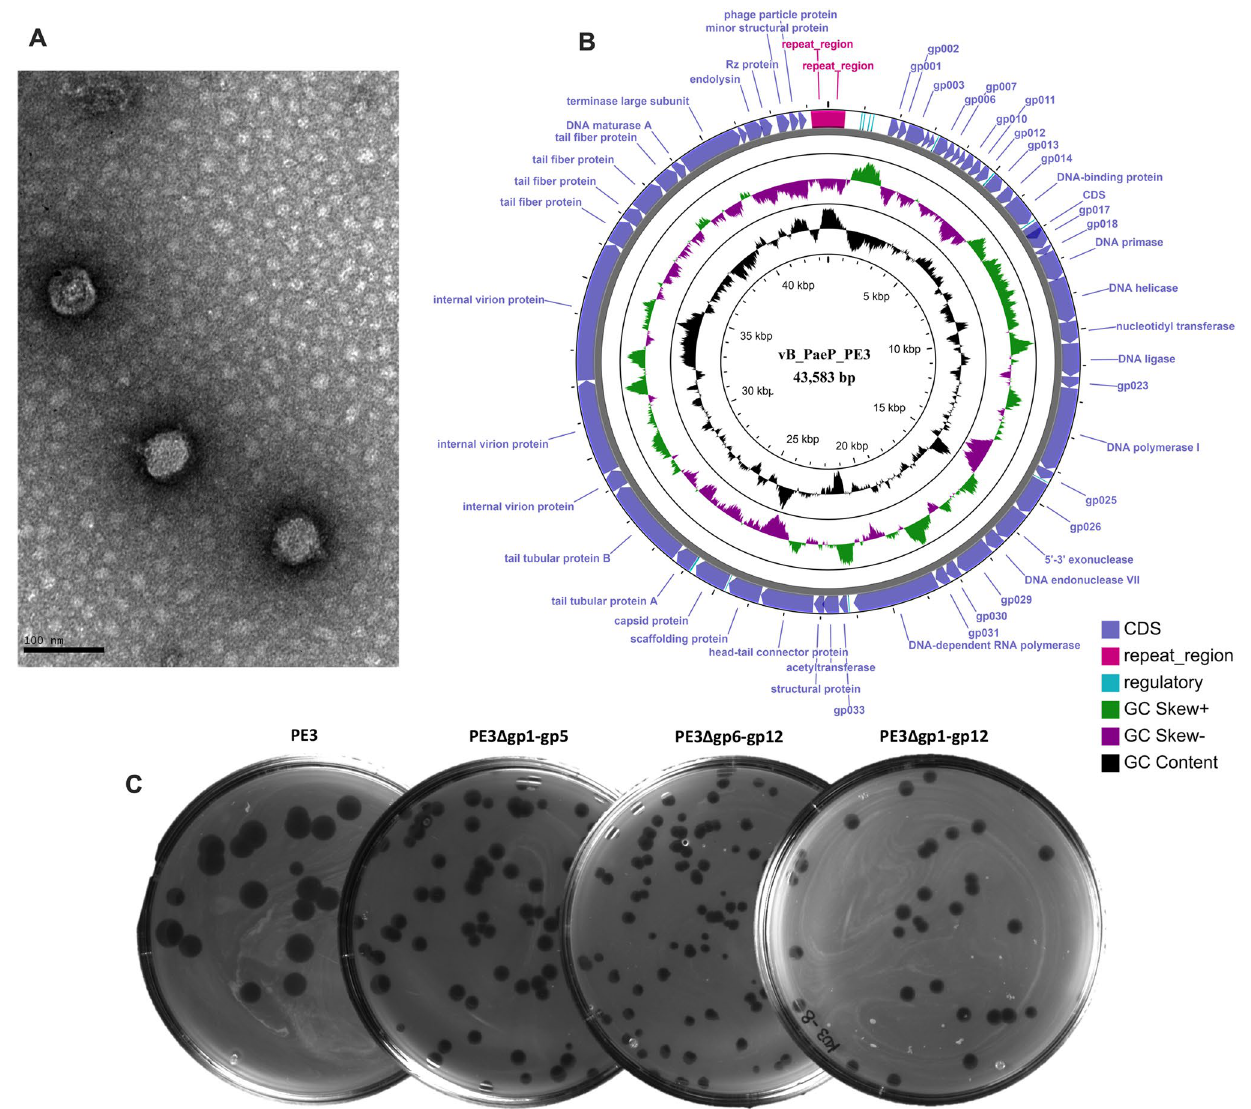
Figure 1. Phage characterization. ( A ) TEM observation of phage PE3. The bar indicates 100 nm. ( B ) Circular view of phage PE3 genome. Created using CGView server 16 . ( C ) Phage plaques of the wild-type and synthetic